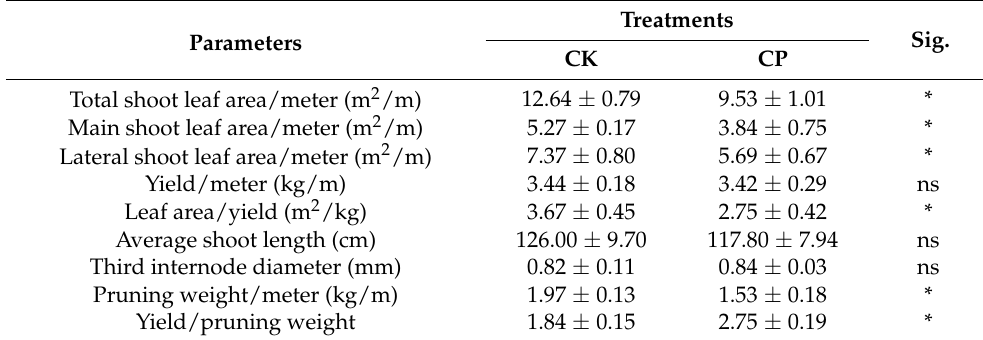
Table 2. Vine parameters of clean tillage control (CK) and covering purslane (CP) of ‘Cabernet- Sauvignon’ in the year 2019.